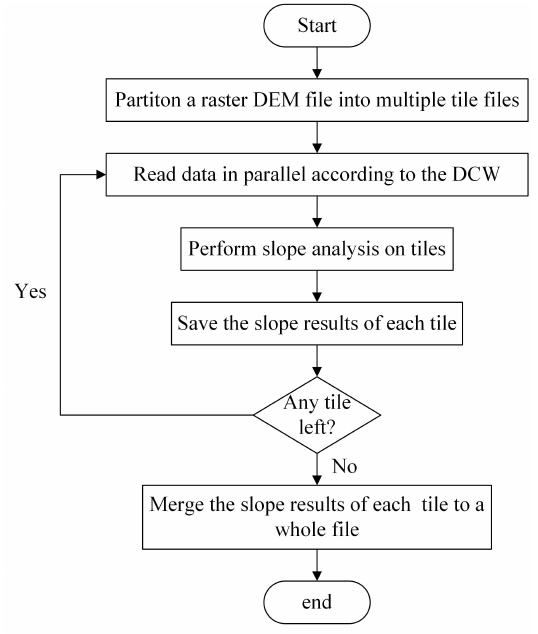
Figure 1. The flowchart of the neighboring analysis using Spark.